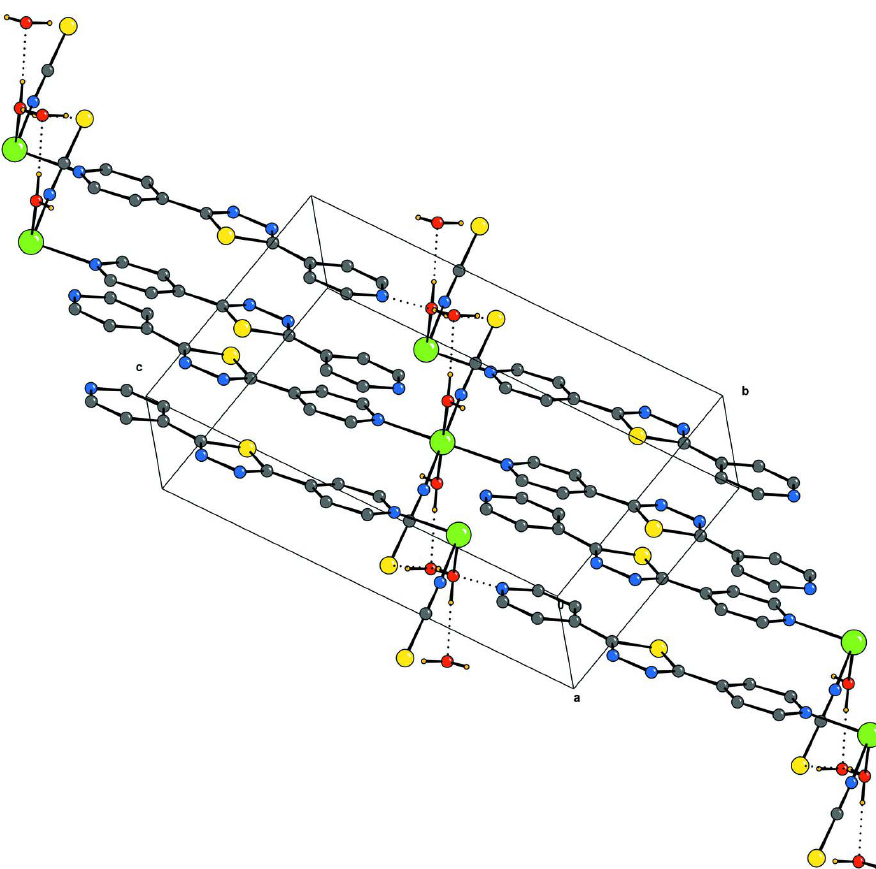
A partial packing view showing the formation of the two dimensional sheet through O-H···O, O-H···N and O-H···S hydro- gren bonds. H bonds are represented as dashed lines. H atoms not involved in hydrogen bondings have been omitted for